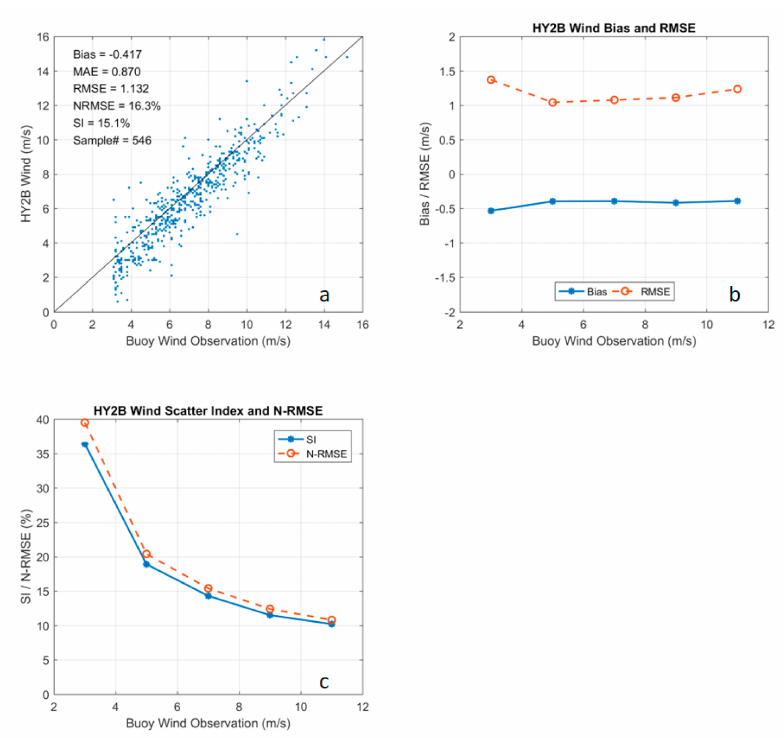
Figure 3. The validation of HY2B wind speed against NDBC buoys. ( a ) Indicates the scatters and the statistical parameters; ( b ) indicates the bias and RMSE distribution with the wind speed;( c ) indicates the SI and NRMSE distribution with the wind speed.